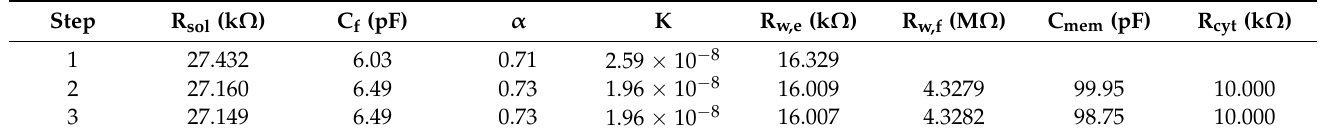
Table 1. Sample of extracted parameters based on curve fitting on GM and CGM from the above